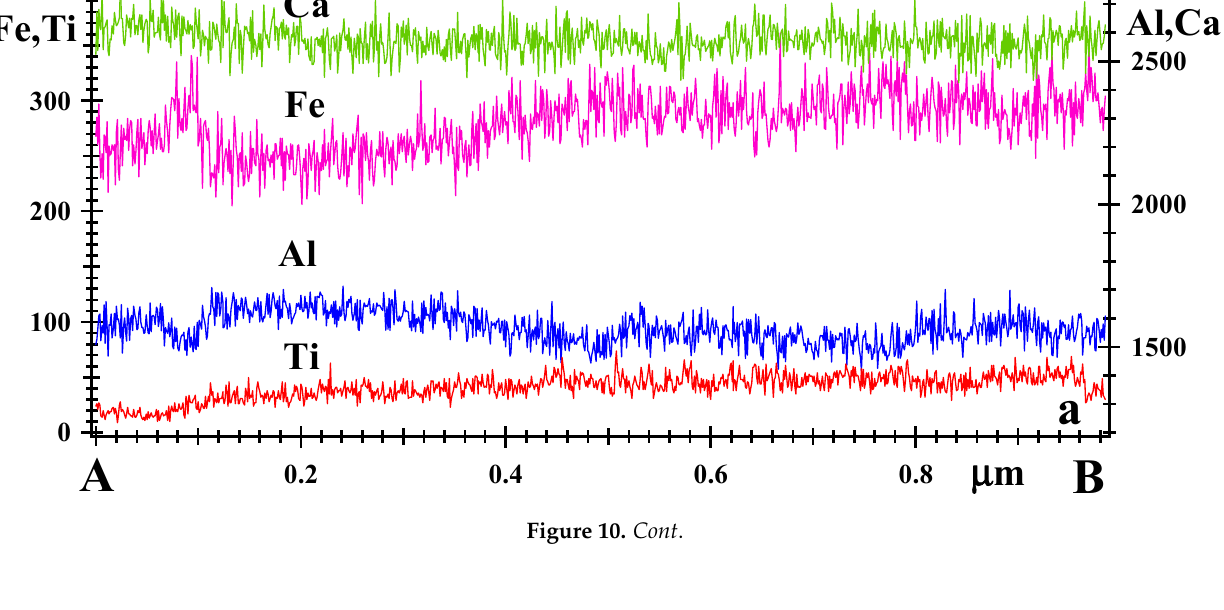
Figure 10. ( a ) Line scans along the line A to B in Figure 9c showing the inverse relation between Fe 3+ and Al 3+ cations, homogeneous Ca, and variable Ti distributions. The scans indicate Fe-poor and Fe-rich phases. ( b ) Quantitative chemical analyses from points 1 to 10 showing the inverse relation between Al and Fe atoms in the Y site (Figure 9c; Table 1). Note that Fe + Al = 2 apfu . The line scan units are arbitrary. 3.3. High-Resolution Powder X-Ray Diffraction (HRPXRD) Traces In Rietveld structure refinements, it is necessary to show the fit of the complete trace to show how well the structure was modelled. In addition, expanded parts of the trace are also needed to observe splitting, asymmetry, width, and sharpness of diffraction peaks. Multiple cubic phases in garnets are easily observed with HRPXRD. An example of a complete HRPXRD trace is shown for a single cubic phase of sample-1 (Figure 11a) and two cubic phases in sample-4 (Figure 11b). The complete traces for the other samples are also given (Figures 12–14). The expanded HRPXRD traces for sample-1 shows a single cubic phase, where the peaks are very sharp and symmetrical (Figure 15a), whereas the two cubic phases in sample-4 are indicated by split peaks, especially for reflections 664, 12,8,2, and 12,6,6 (Figure 15b).